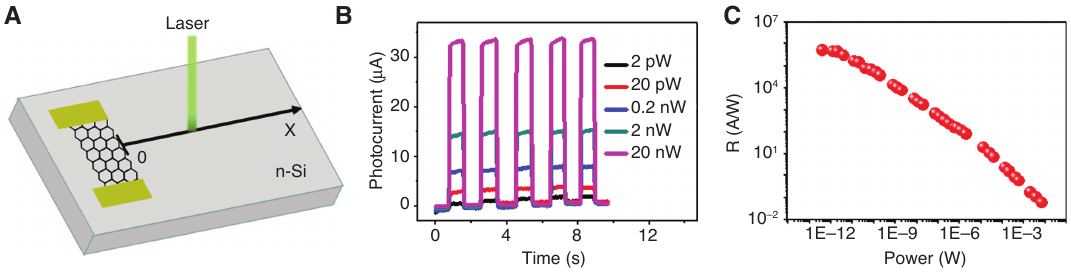
Figure 1: Photoresponse of the graphene device. (A) Schematic view of the graphene devices on lightly n-doped Si. X represents the distance of the laser illumination position from the graphene channel. (B) Photo-switching characteristics and (C) photoresponsivity of the device act as a photodetector at different power = 1 (X = 0 μ m, V ds